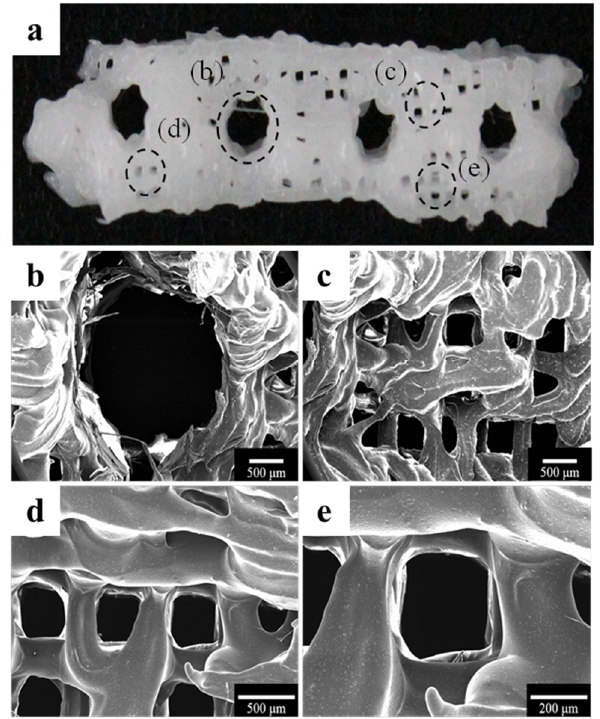
Figure 2. Morphology of the polycaprolactone (PCL)/ β -tricalcium phosphate ( β -TCP) scaffold. ( a ) Visual image of the scaffold; ( b ) An implant through hole, which plays a role in guiding the implant fixture and ( c – e ) The interconnected pores on the scaffold.